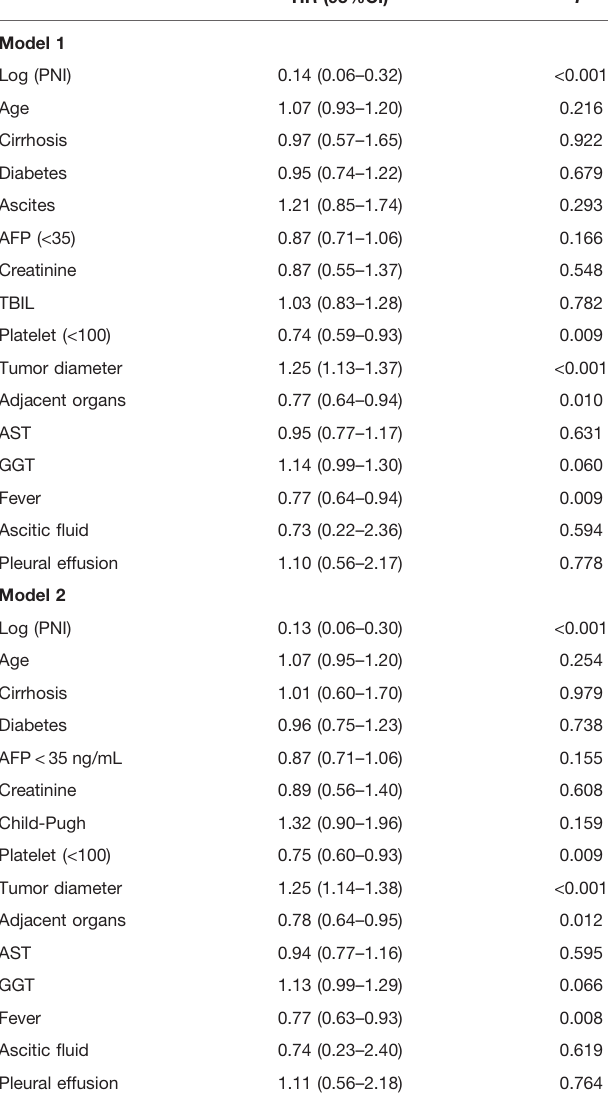
TABLE 2 | Multivariate analysis of prognostic factors of OS in HCC patients with HBV infection following US-PMWA by two